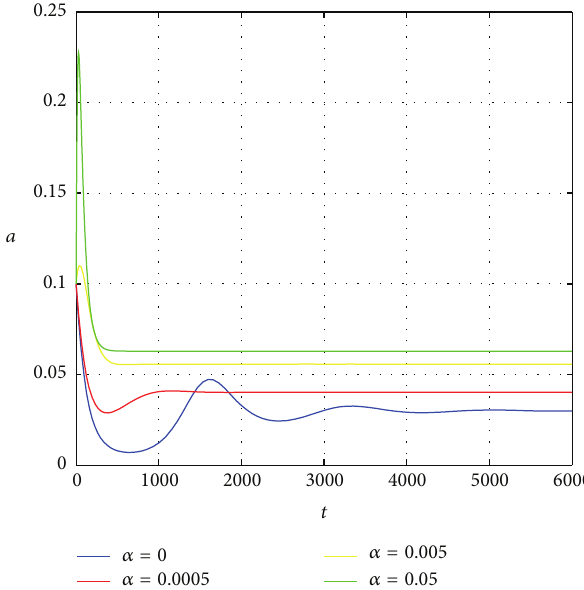
increases, and the speed tending to steady states becomes more